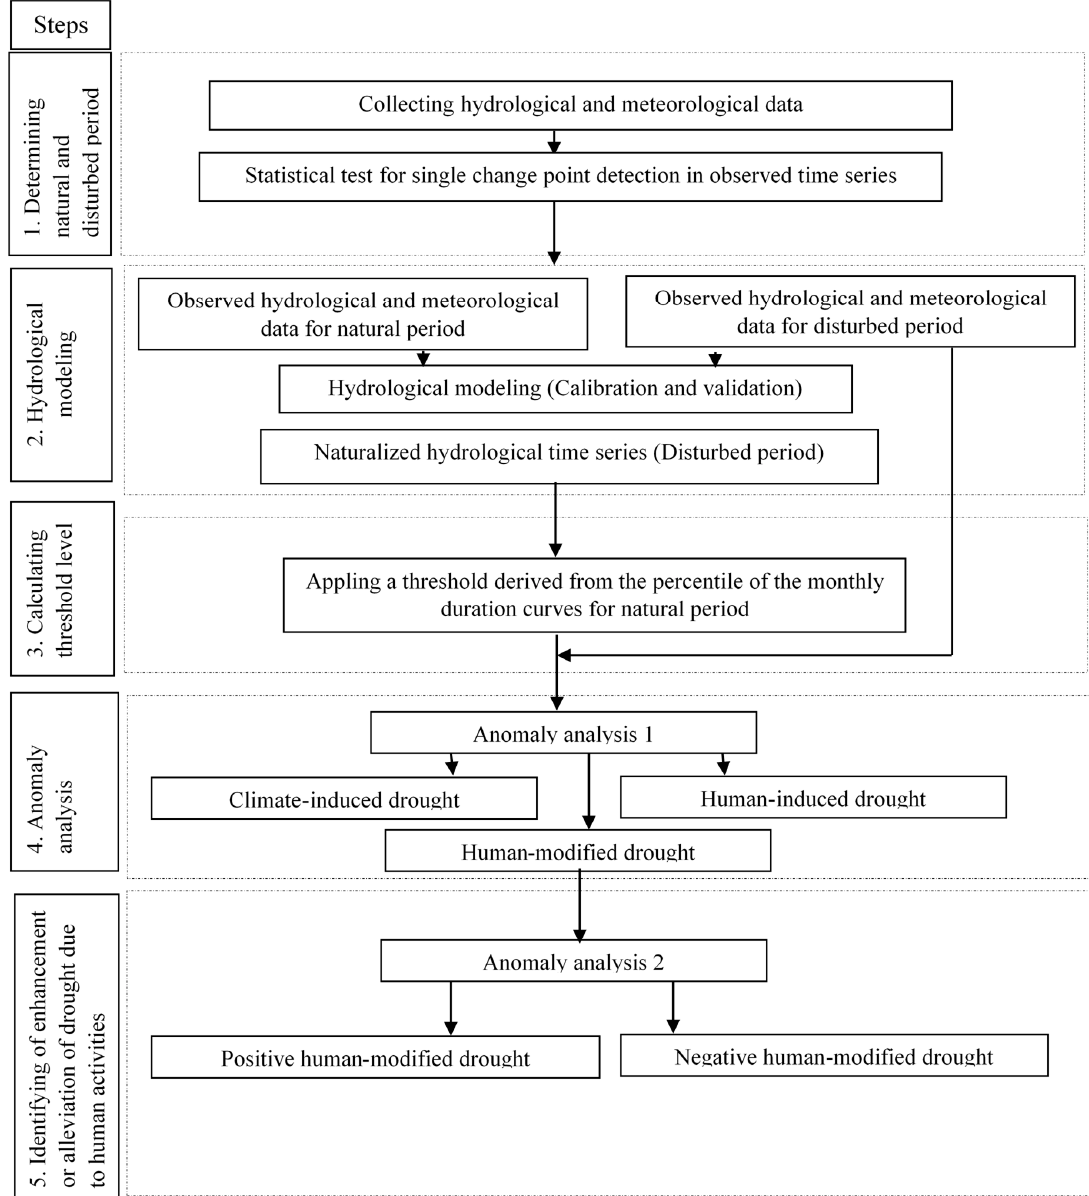
Figure 2. The expanded “observation-modelling” approach to quantify droughts in the Anthropocene.